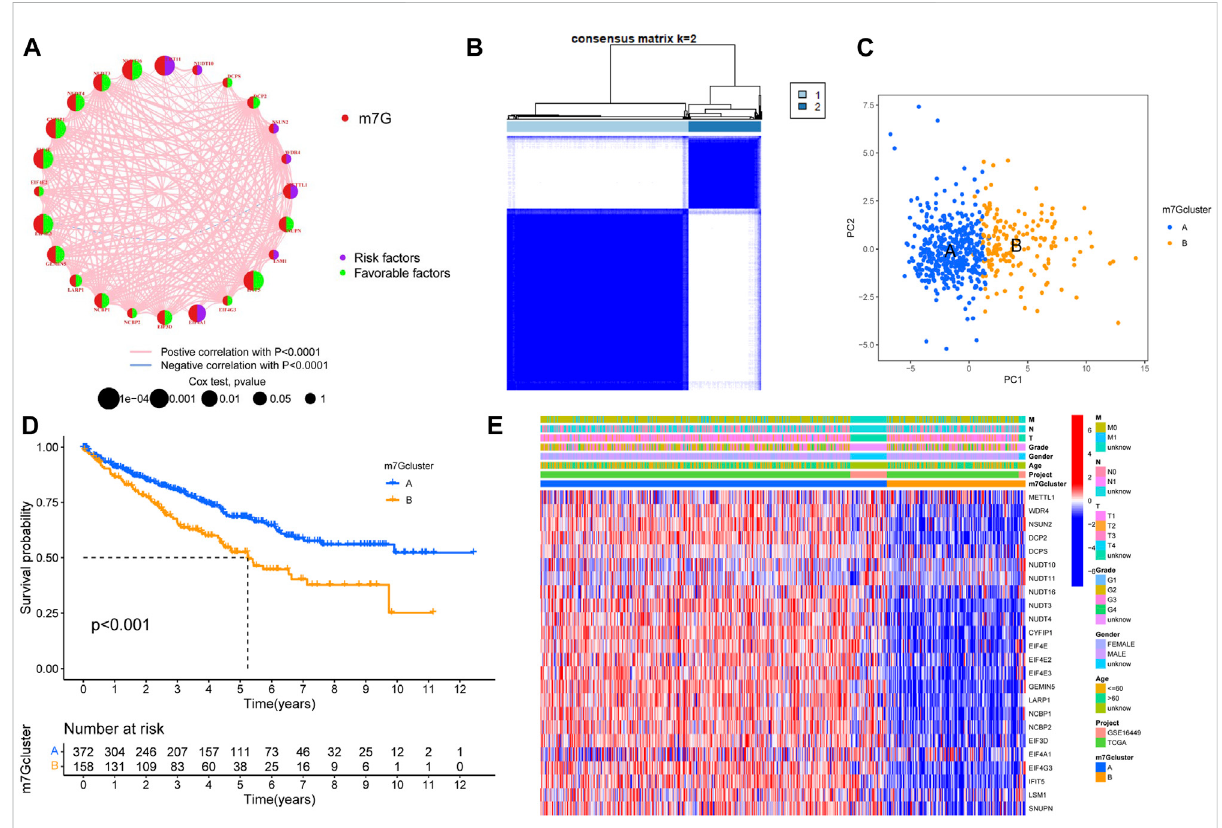
Characteristics of m7G subtypes. (A) The correlations between m7G-related genes; the line indicates that the two were related, the red line represented the positive correlation, the blue line represented the negative correlation, and the size of the node represented the prognostic correlation. (B) M7G-related genes were divided into two subtypes. (C) PCA analysis showed that there were signi fi cant differences among different subtypes. (D) Survival analysis of different subtypes. (E) The expression of m7G-related genes in different subtypes and the clinical characteristics of the subtypes. PCA, principal components